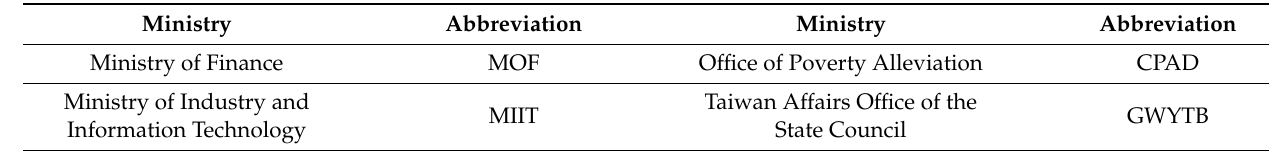
Table A1. The abbreviations of Chinese central government